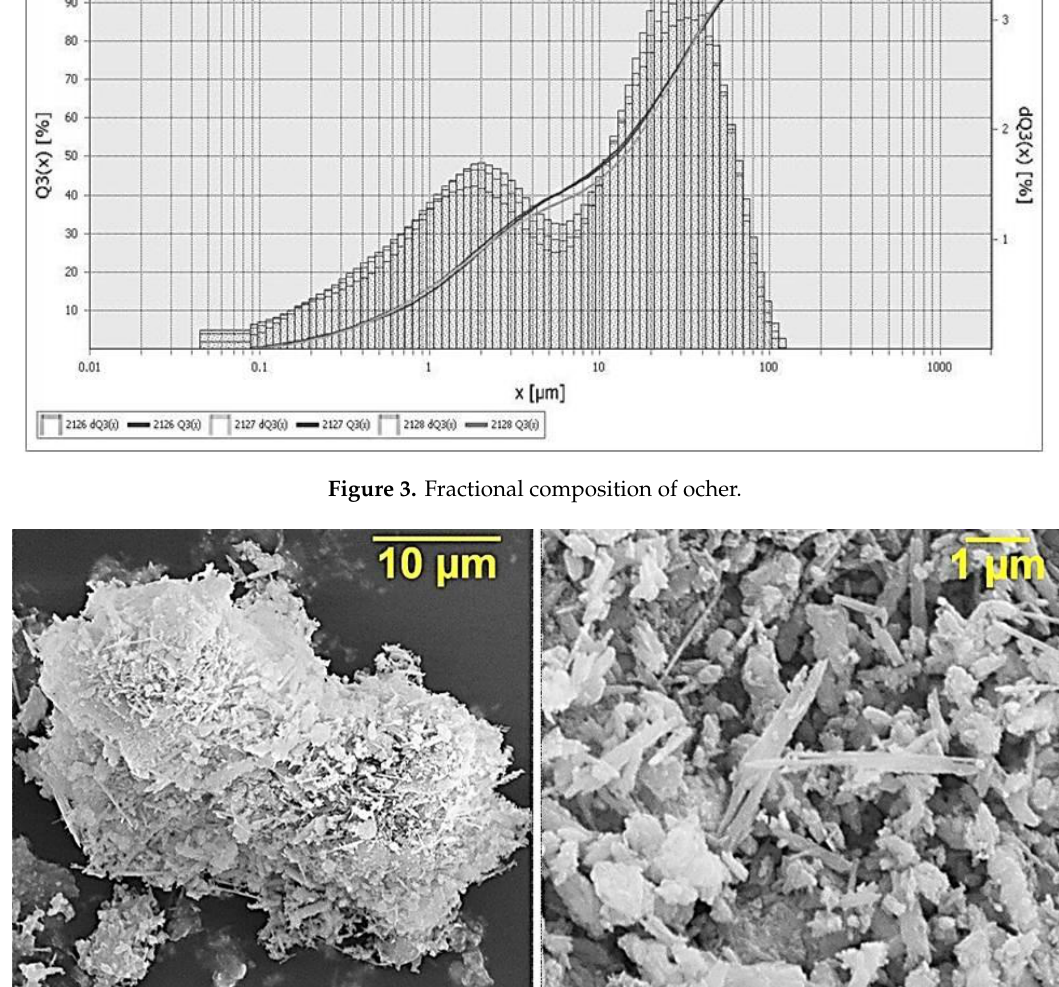
Figure 5. XRF pattern of ocher particles: 1 — FeO(OH) goethite; 2 — Fe 2 O 3 hematite; 3 — Fe 3 O 4 magnetite. Goethite has needle-shaped crystals, hematite crystals are flattened, from tabular to scaly or lamellar, magnetite is represented by cubic crystals. In addition, magnetite has strong magnetic properties, which imparts magnetic properties to composite materials, and thereby expands the possible areas of their application.